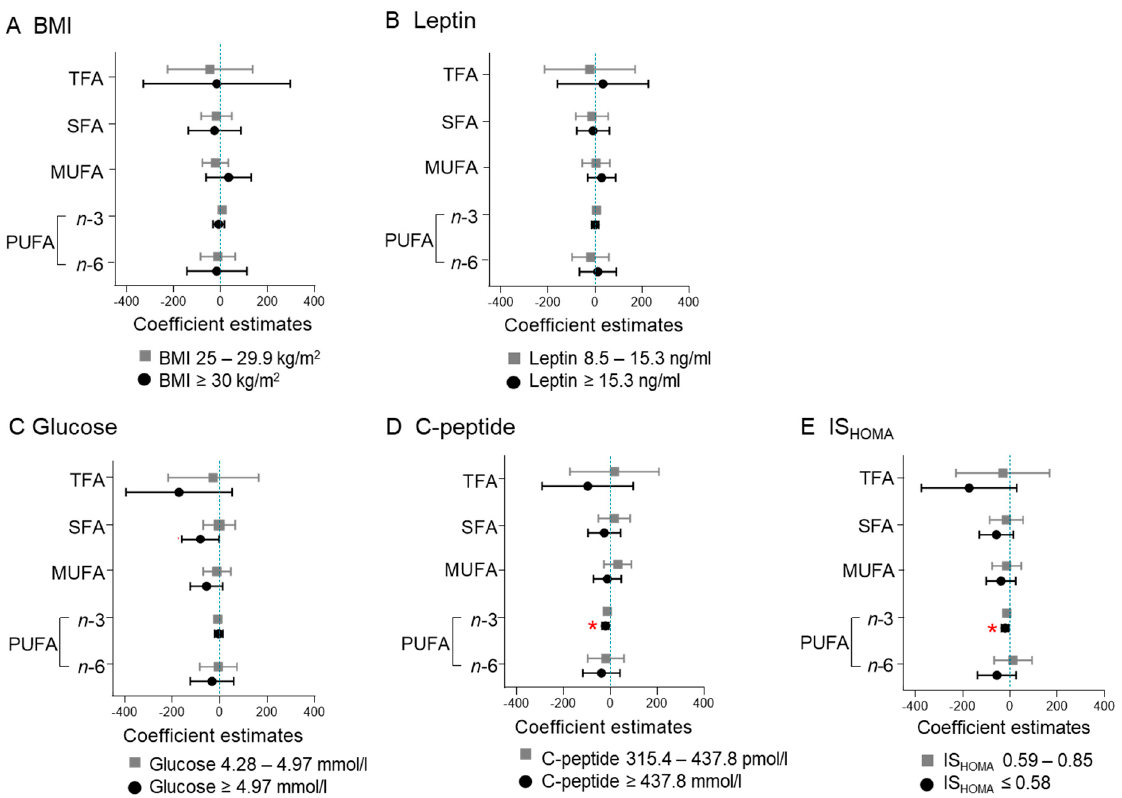
Figure 1. Maternal C-peptide and IS HOMA , but not maternal BMI or leptin, associate with n -3 PUFA. Measures of maternal obesity (BMI) ( A ), adiposity (leptin) ( B ) and of the glucose–insulin axis (glucose, C-peptide, and IS HOMA ) ( C – E ) were categorized into tertiles and the estimates compared to the reference category: BMI < 25 kg/m 2 , leptin < 8.5 ng/mL, glucose < 4.28 mmol/L, C-peptide < 315.4 pmol/L, IS HOMA > 0.85. SFA: sum of 14:0, 16:0, and 18:0; MUFA: sum of 16:1, 18:1, and 22:1; n -3 PUFA: sum of 18:3, 20:3, 20:5, 22:5, and 22:6; n -6 PUFA: sum of 18:2, 18:3, 20:3, 20:4, 22:2, 22:4, and 22:5. Model adjusted for gestational age (days), maternal age (years) and processing time (minutes). * Statistically significant difference after correction for multiple testing (FDR = 0.2).